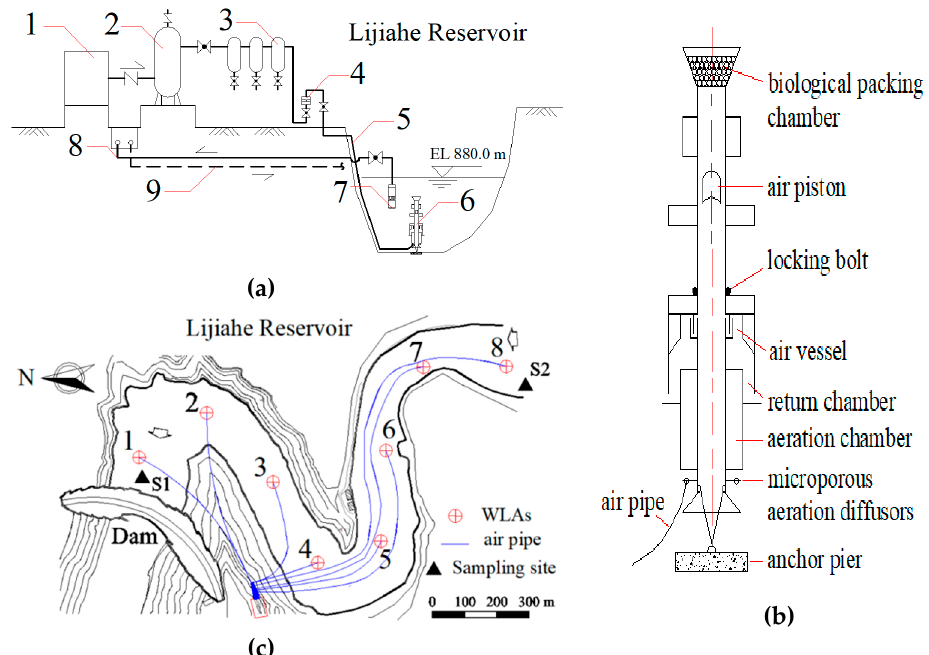
Figure 2. The water lifting aeration system: ( a ) sketch of the water lifting and aeration system, ( b ) layout of the water lifting aerators in Lijiahe Reservoir, ( c ) diagram of the water lifting aerator structure. 1-air compressor; 2-gas holder. 3-air filter; 4-flowmeter; 5-air pipe; 6-WLAs; 7-cooling water pump; 8-cooling pipe; 9-return pipe.